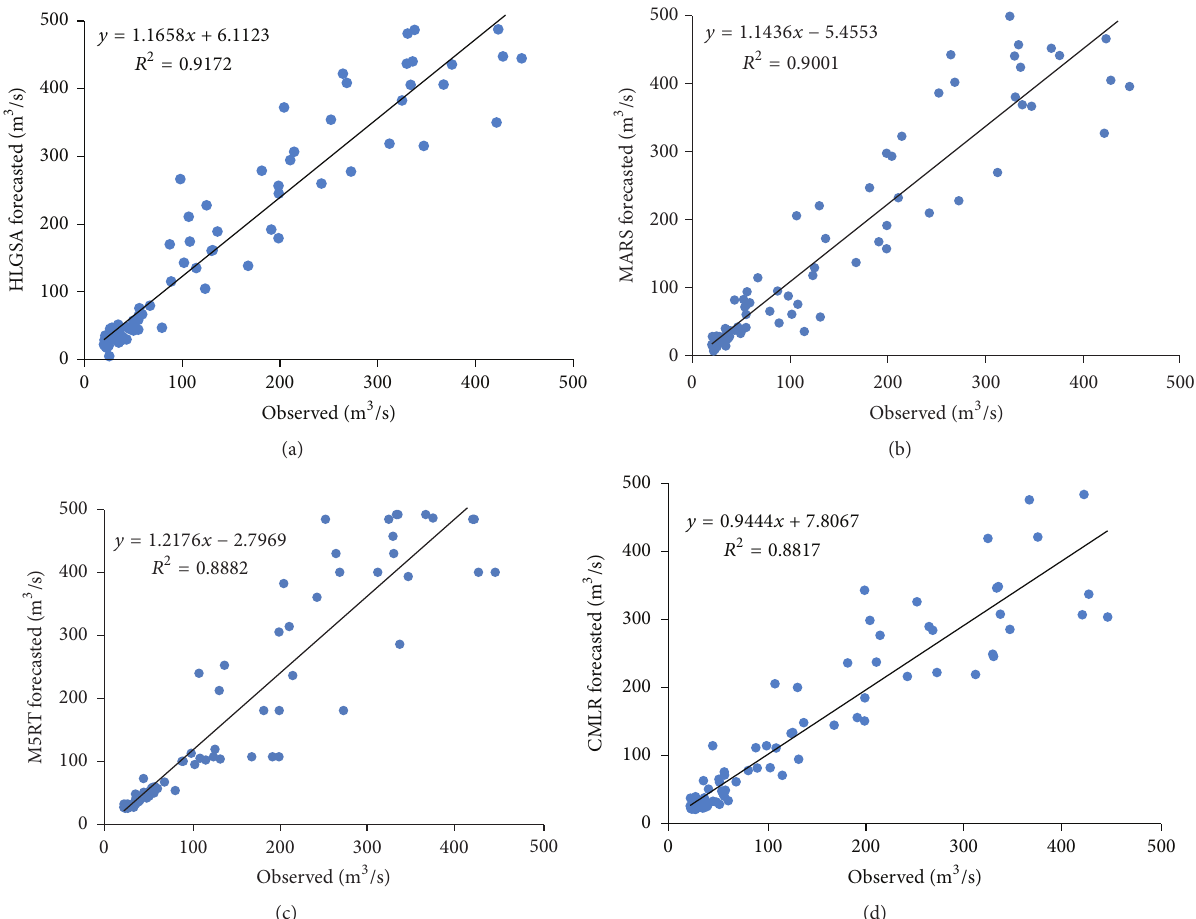
Figure 6: The observed and forecasted river flow by the HLGSA, MARS, M5RT, and CMLR models using DS4 data set: Astore catchment.